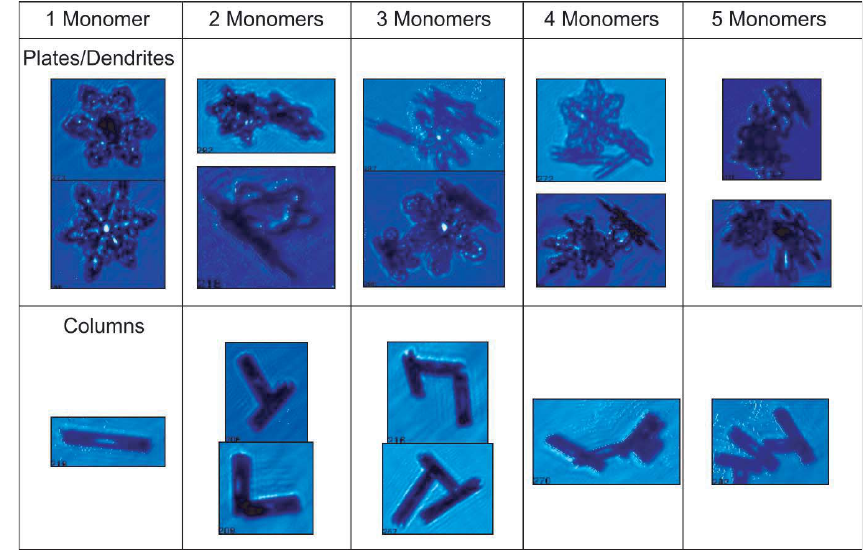
Fig. 15. Some examples of aggregated ice crystals of either planar or columnar habit, with 1, 2, 3, 4 and 5 monomers.